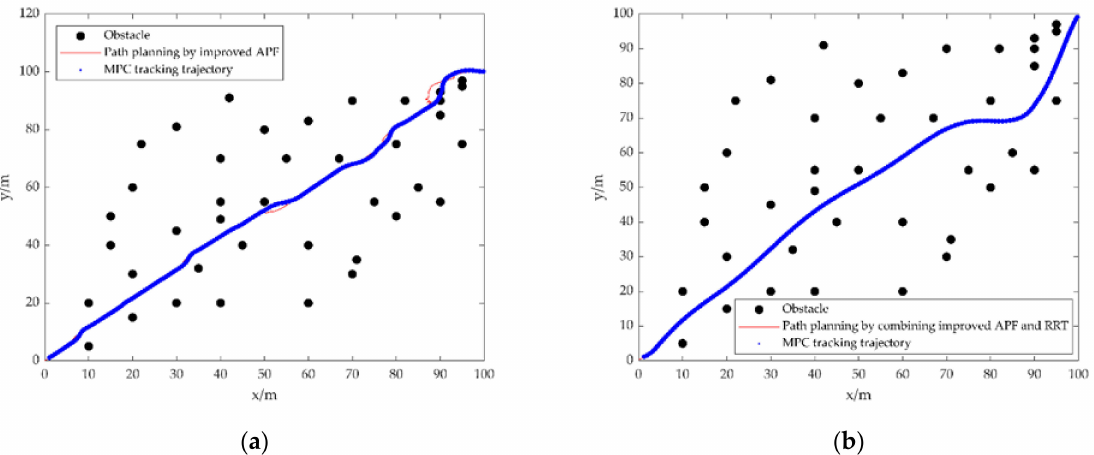
Figure 8. ( a ) MPC tracks the trajectory planned by the improved APF method; ( b ) MPC tracks the trajectory planned by the combination of the improved APF method and the RRT